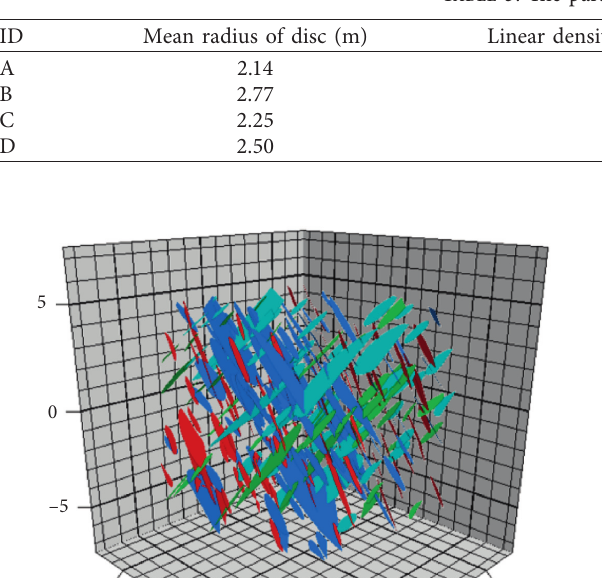
Table 3: The parameters of joint disc.